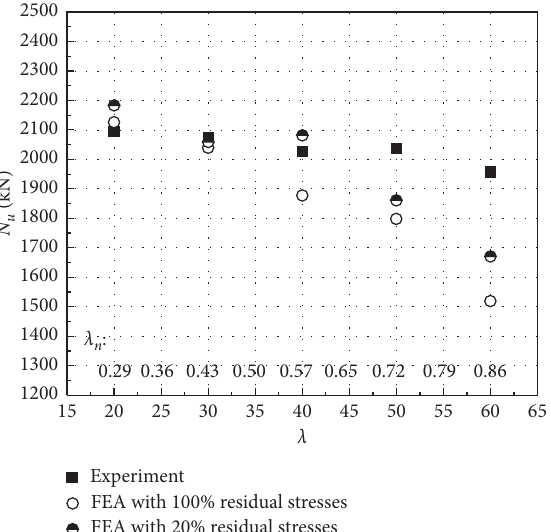
Figure 9: Comparison of axial load capacity with different residual